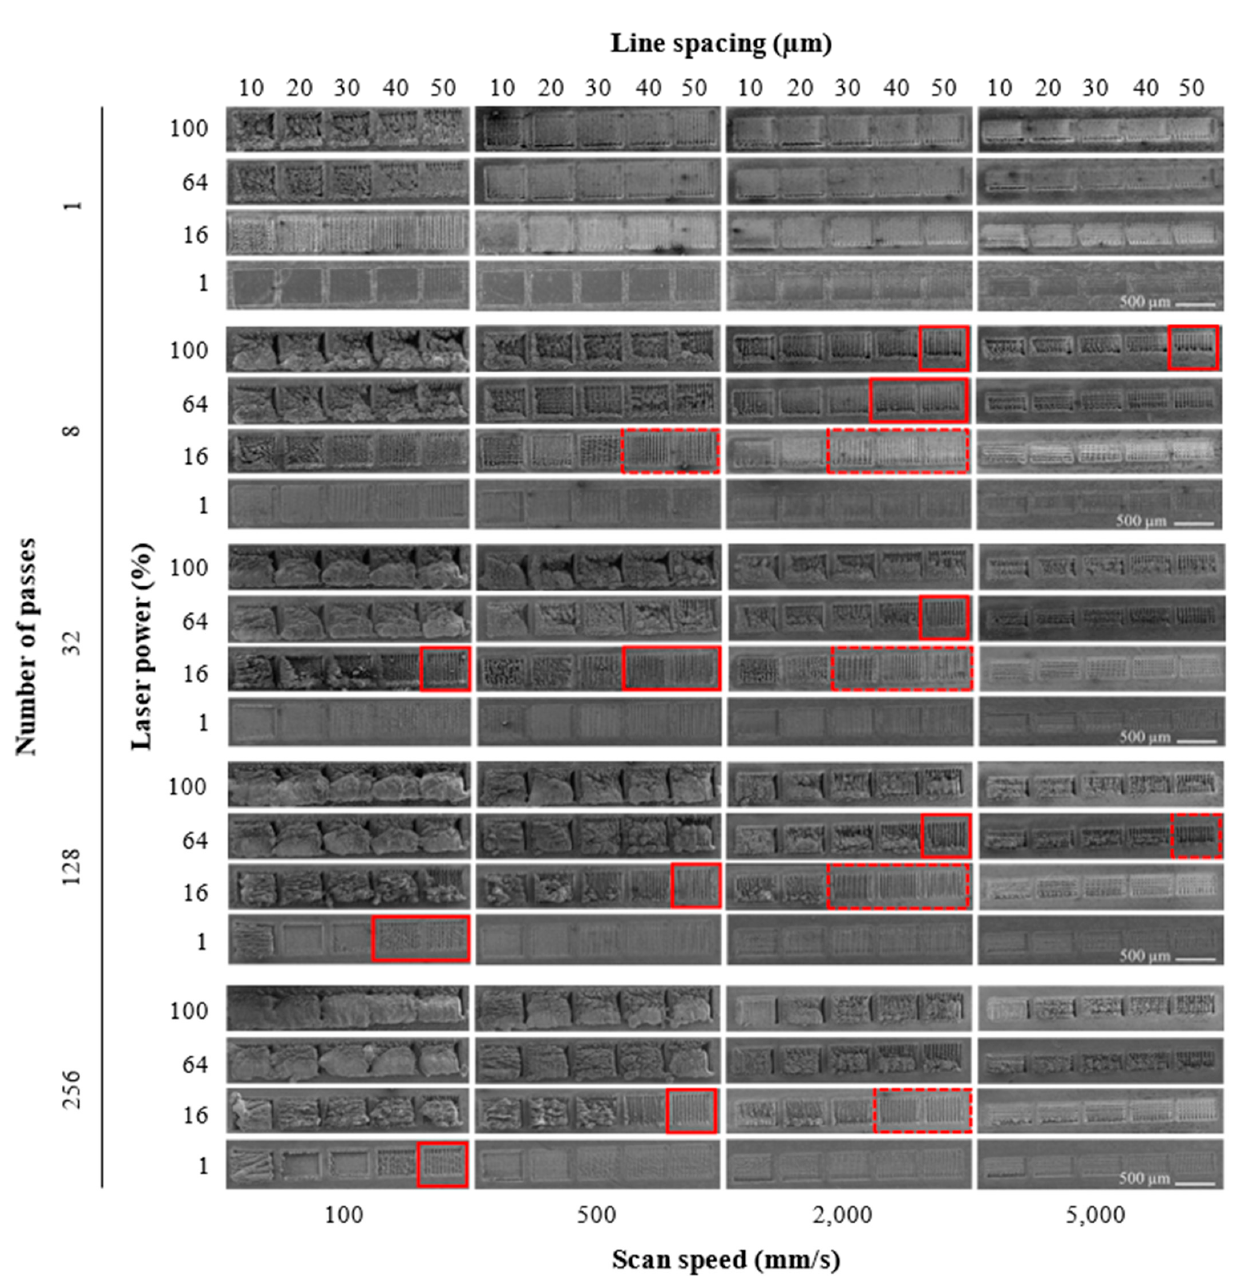
Figure 3. SEM images of textured 420 stainless steel samples subject to different processing parameters (laser power, scanning speed, number of passes, and line spacing).